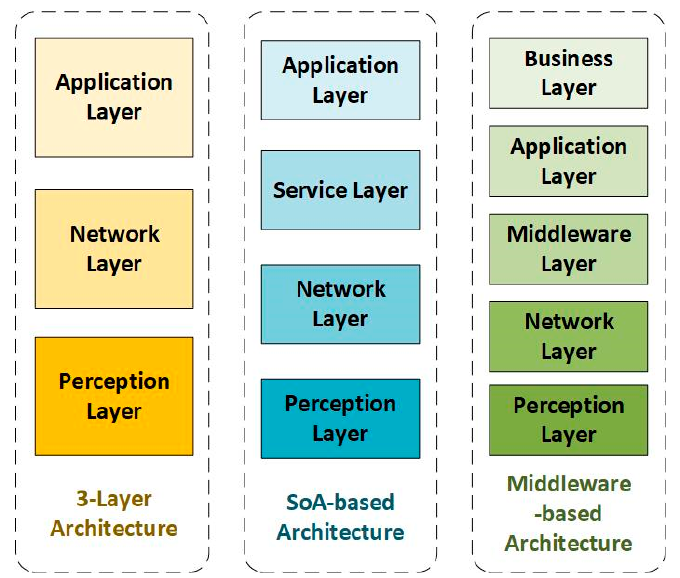
Figure 1. Most common IoT architectures.